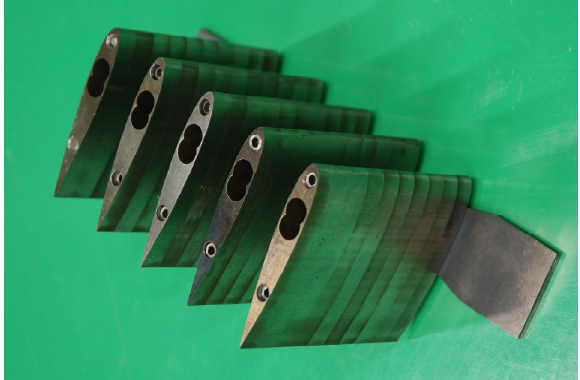
Fig. 7. A photo of blade cascade consisting of five NACA 0015 profiles fixed to support